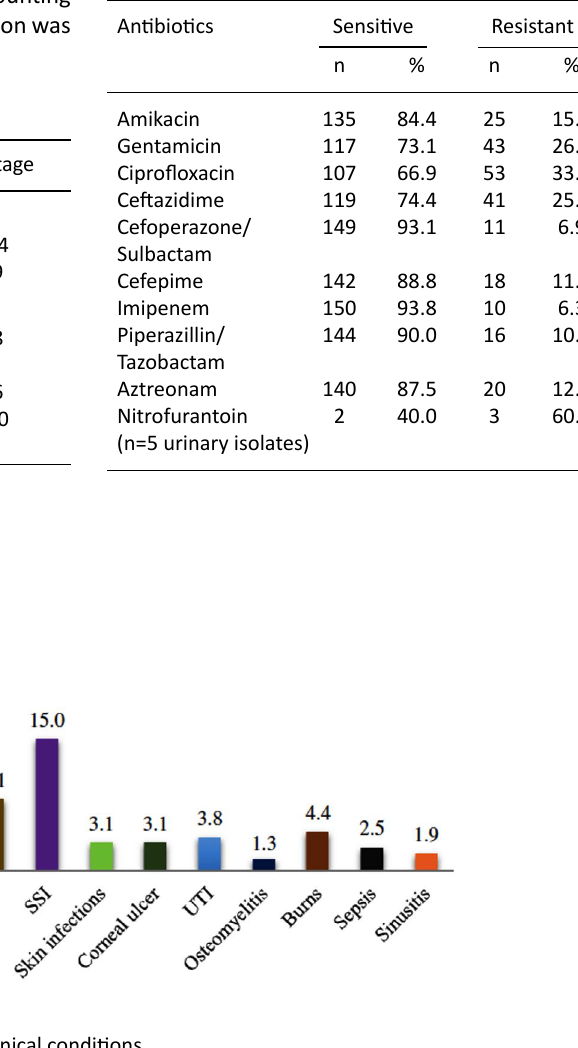
Table 2. Antibiotic susceptibility pattern of isolates